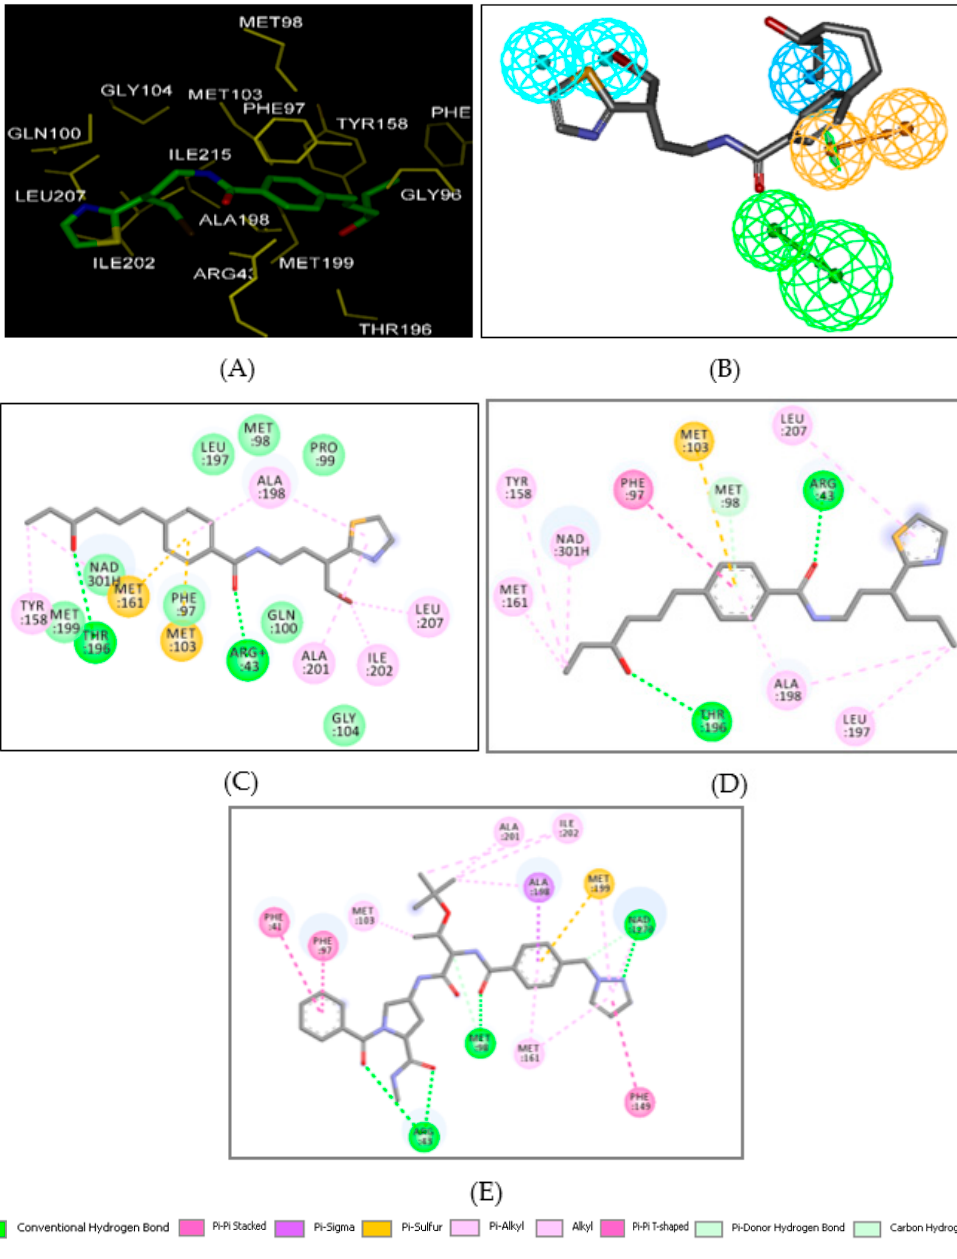
Figure 7. ( A ) Close up of virtual hit 79–92, the most active designed BHMB analog (IC 50pre = 33 pM) at the active site of InhA. Interacting residues are colored yellow, and NADH is not shown for clarity. ( B ) Mapping of the BHMB 79–92 to InhA inhibition pharmacophore. ( C ) 2D schematic interaction diagram of the BHMB 79–92 at the active site of Mt InhA. ( D ) 2D schematic interaction diagram of the analog BHMB 79–339 (IC 50pre = 39 pM) at the active site of Mt InhA. ( E ) 2D schematic interaction diagram of the ligand ((2S,4S)-N-methyl-4-[[(2S,3R)-3-[(2-methylpropan-2-yl)oxy]-2-[[4-(pyrazol-1- ylmethyl)phenyl]carbonylamino]butanoyl]amino]-1-(phenylcarbonyl)pyrrolidine-2-carboxamide) in complex with Mt InhA (PDB: 5G0W) displaying the HB contact with Arg43 as reported in [6].